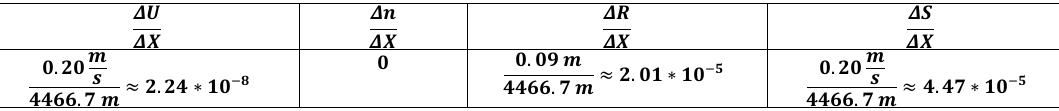
Table 3. Rate of change of the parameters of the